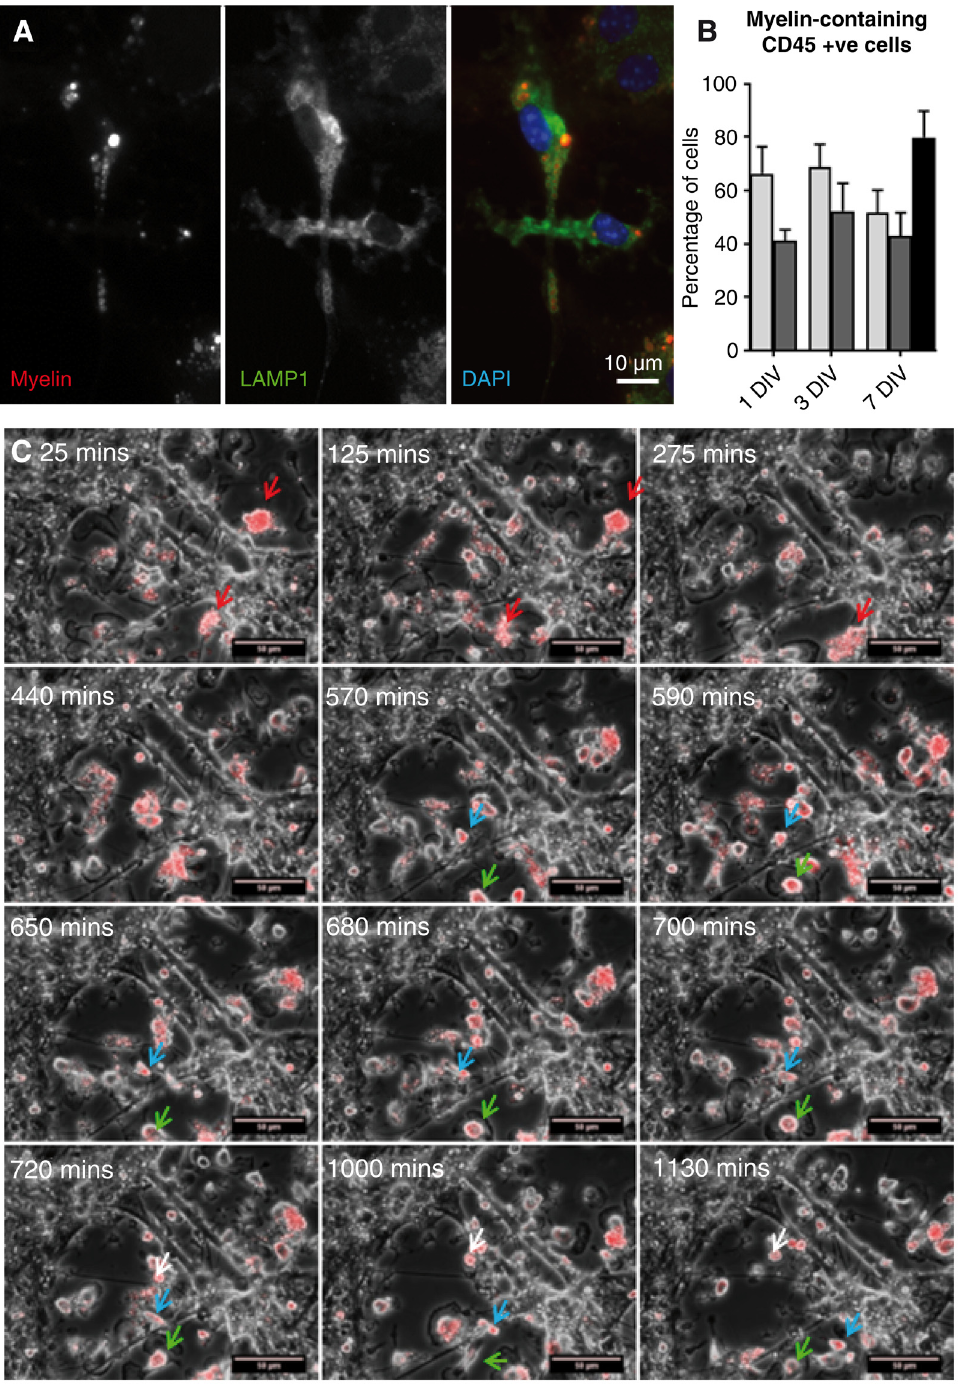
Figure 3. Motile microglia/macrophages take up myelin debris in vitro . ( A ) ID4B antibody staining of cultures treated with rhodamine- labelled myelin debris at 27 DIV shows myelin debris (red) within lysosomal associated membrane glycoprotein 1 (green) late endosomes/ lysosomes. All cells containing myelin were found to be CD45 +ve (not shown). ( B ) After incubation with saturating amounts of myelin debris (data obtained with 0.075 or 0.1 mg myelin protein ml -1 were similar, so values from each were included providing two technical replicates) over three different time periods, the percentage of CD45 positive cells that contained ‘wild type’ (pale grey bars) or Plp1 -tg (dark grey bars) myelin debris, which is taken up in a receptor-dependent manner, was between 40–70 % (n = 6; 2 technical replicates for each of 3 independent experiments, per time point); not significantly different from the proportion that contained latex beads (black bar), which are taken up in a receptor-independent manner (n = 3 independent experiments). Bars represent mean +/- s.e.m.. ( C ) Time lapse stills over 1130 minutes show myelin debris (red) at time of addition (25 mins – 275mins) and then being phagocytosed by microglia/macrophages (440 mins – 1130 mins). Blue and green arrows highlight the locations of individual cells over